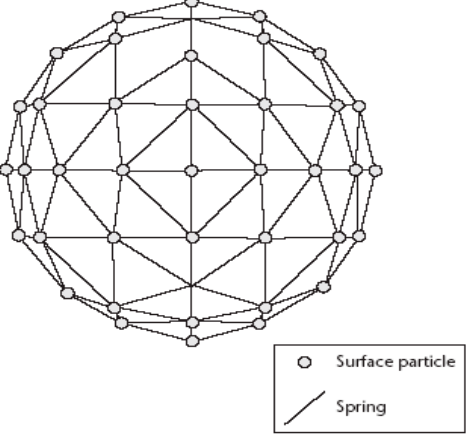
Figure 1. A model of spring-mass system with particles joined by links.